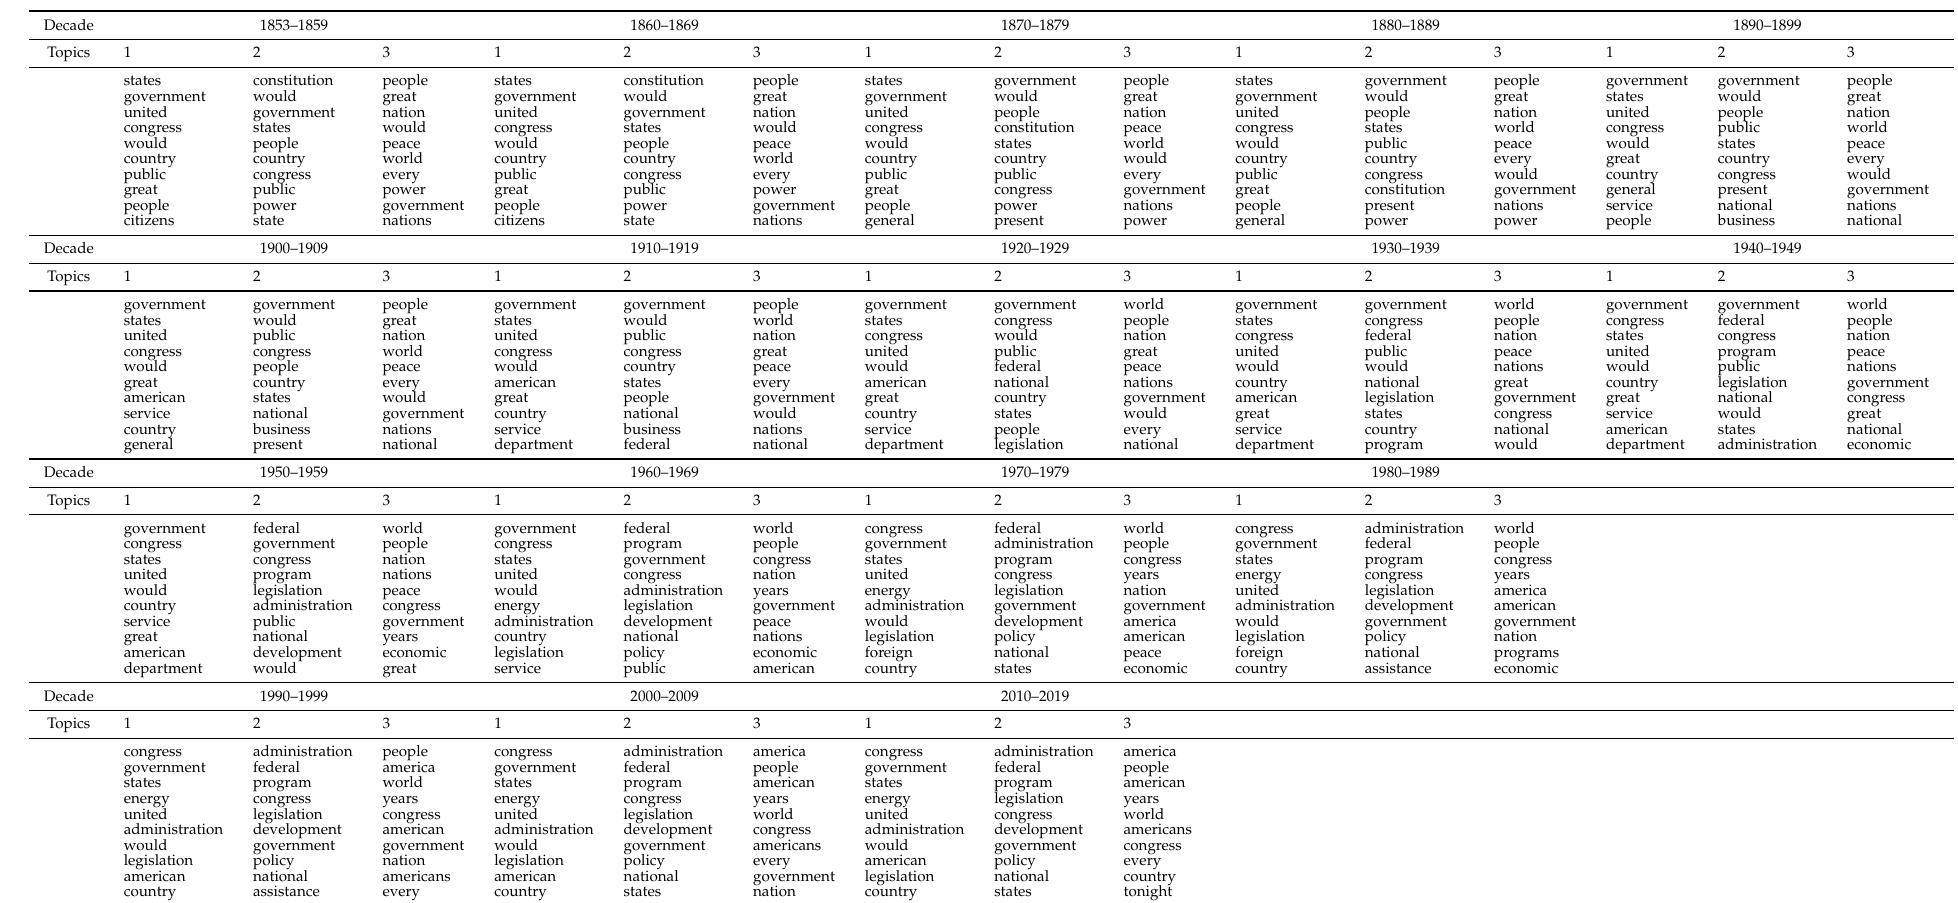
Table 4. Top 10 words from an estimated Dynamic Topic Model (per decade) with 3